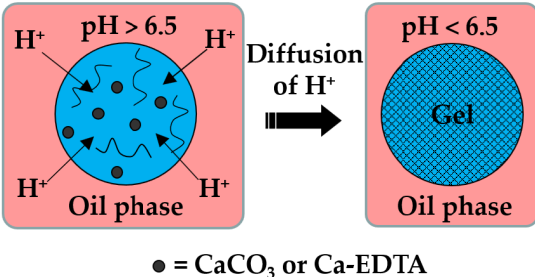
Figure 1. Formation of alginate beads by internal gelation. The organic acid dissolved in the oil phase dissociates at the droplet interface into acetate anions and hydrogen cations, and the pH drops below 6.5. Released H + ions react with CaCO 3 or Ca-EDTA dispersed or dissolved within the droplet, thereby releasing the Ca 2+ ions that crosslink the polymer.